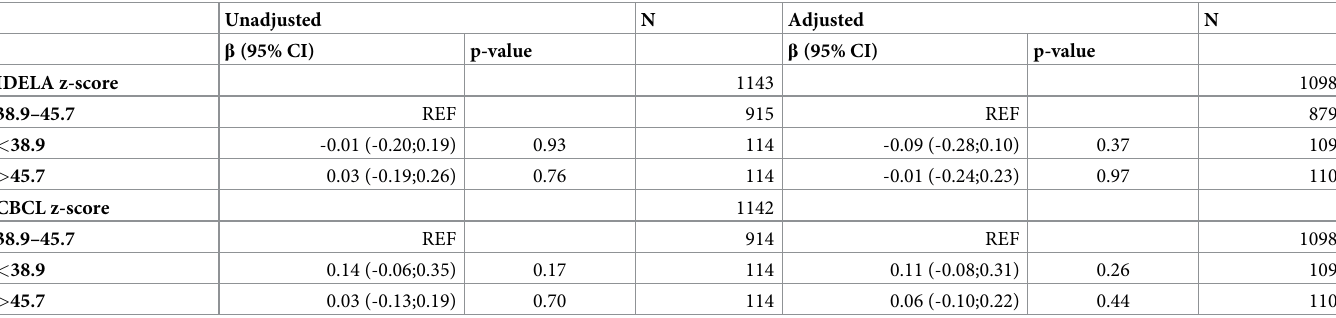
Table 3. Unadjusted and adjusted � association of bottom and top decile exposure to NO 2 [ μ g/m3] with IDELA (z-score) and CBCL (z-score). Unadjusted